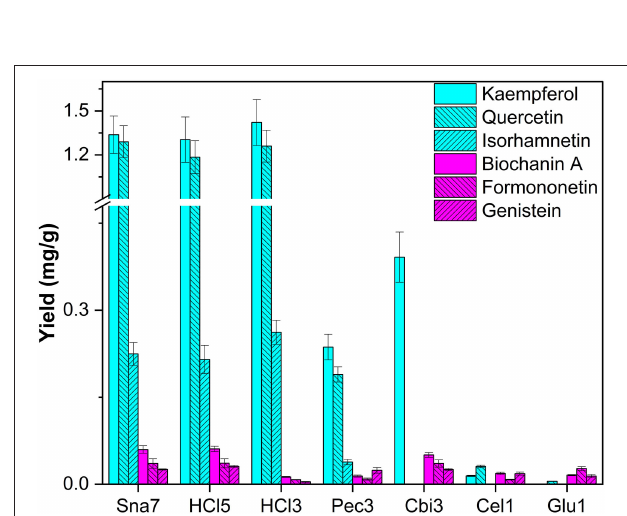
FIGURE 6 | Aglycone yields (mg/g) from flower extracts of T. pratense . Enzymatic hydrolysis (25min): Sna7: 5mg snailase (pH 5.5, 37 ◦ C); Pec3: 20U pectinase (pH 4.5, 40 ◦ C), Cbi3: 5U cellobiase (pH 4.5, 37 ◦ C); Cel1: 20U cellulase (pH 5.5, 52 ◦ C); Glu1: 20U β -glucosidase (pH 4.5, 37 ◦ C). Acidic hydrolysis (60min): HCl3: 1M HCl at 70 ◦ C; HCl5: 1M HCl at 100 ◦ C ( n = 3 ±